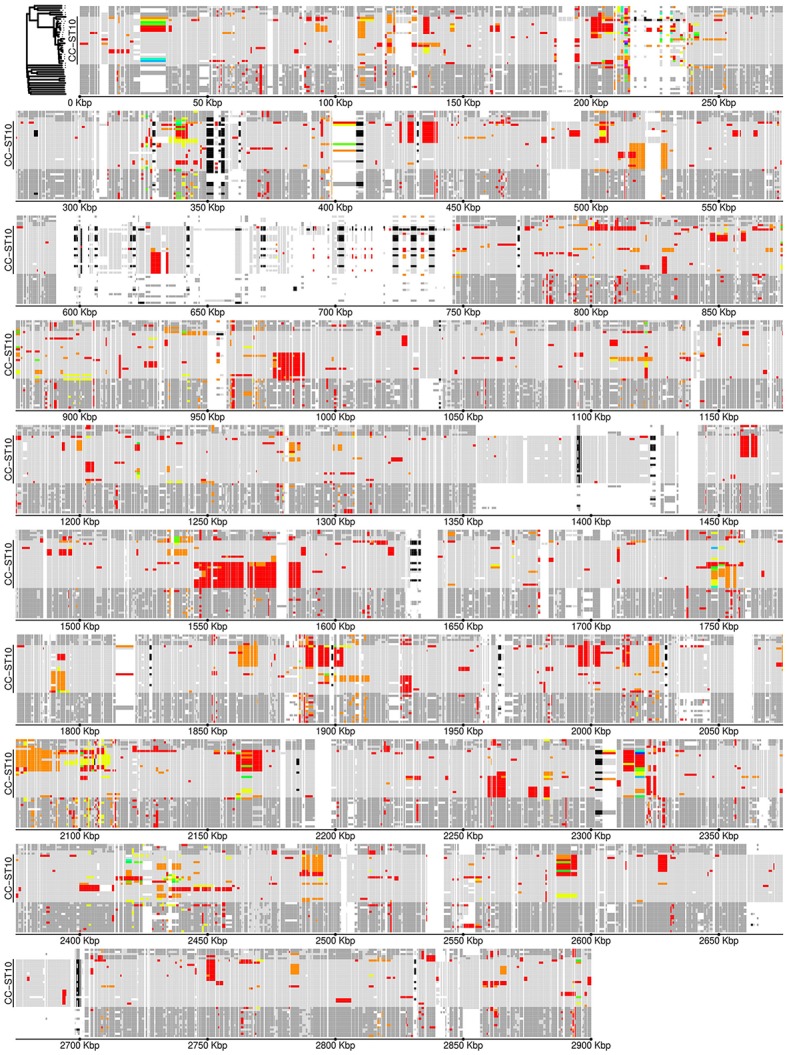
Allele-type map of CC-ST10. Protein coding gene loci are positioned along the genome according to gene coordinates in the genome of strain CSF259-93. Genomes are ordered vertically according to the tree built on AT-profiles as illustrated in the upper-left corner; the exact position of CC-ST10 is reported. Black indicates presence of a gene in more than one copy; white indicates absence. Allele-types in CC-ST10 are represented by different colors: light gray for the main allele-type and red to yellow for the others, with some local reallocations of colors to maximize the consistency of the color choice between adjacent loci. Allele-types not found in CC-ST10 are represented in dark gray.